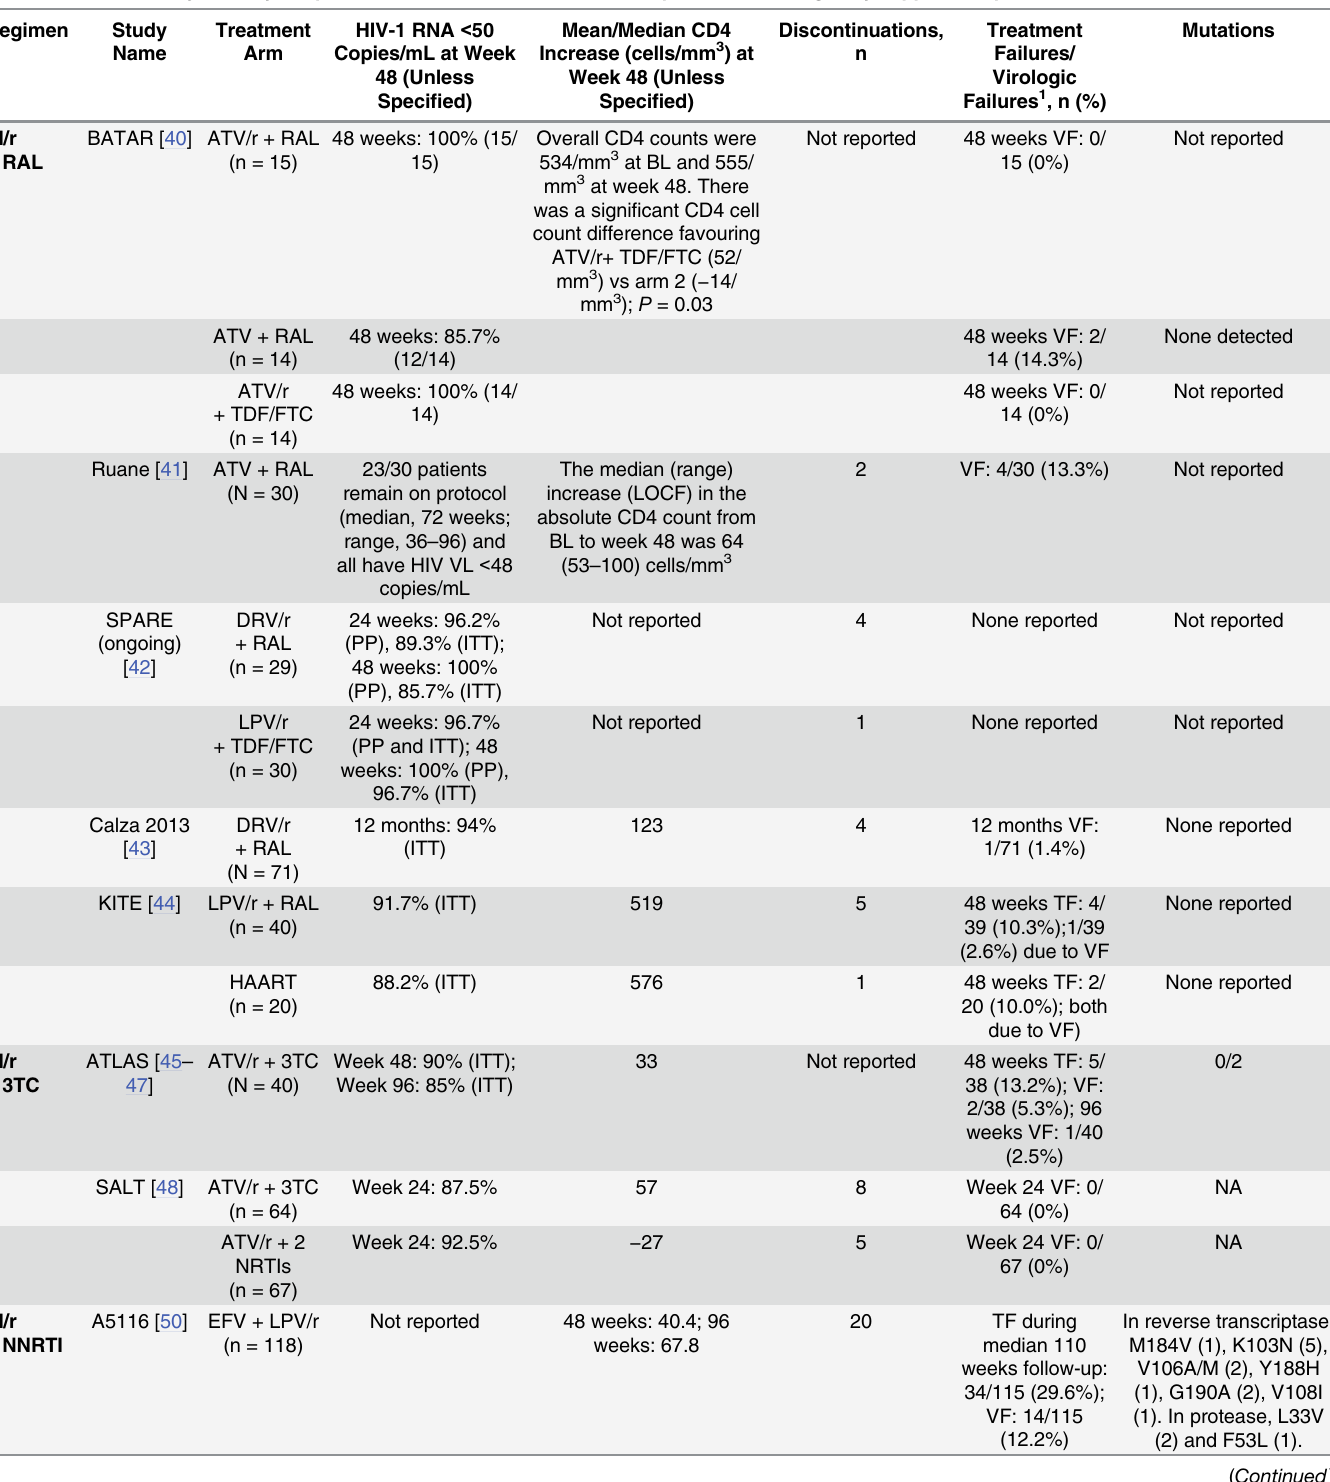
Table 5. Results of key efficacy endpoints from identified trials in ARV-experienced virologically suppressed patients.